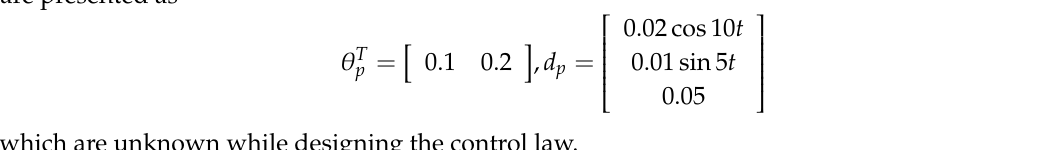
Figure 2. Aircraft response for MRAC and robust adaptive controller with 0.01 λ θ ρ ρ= = .